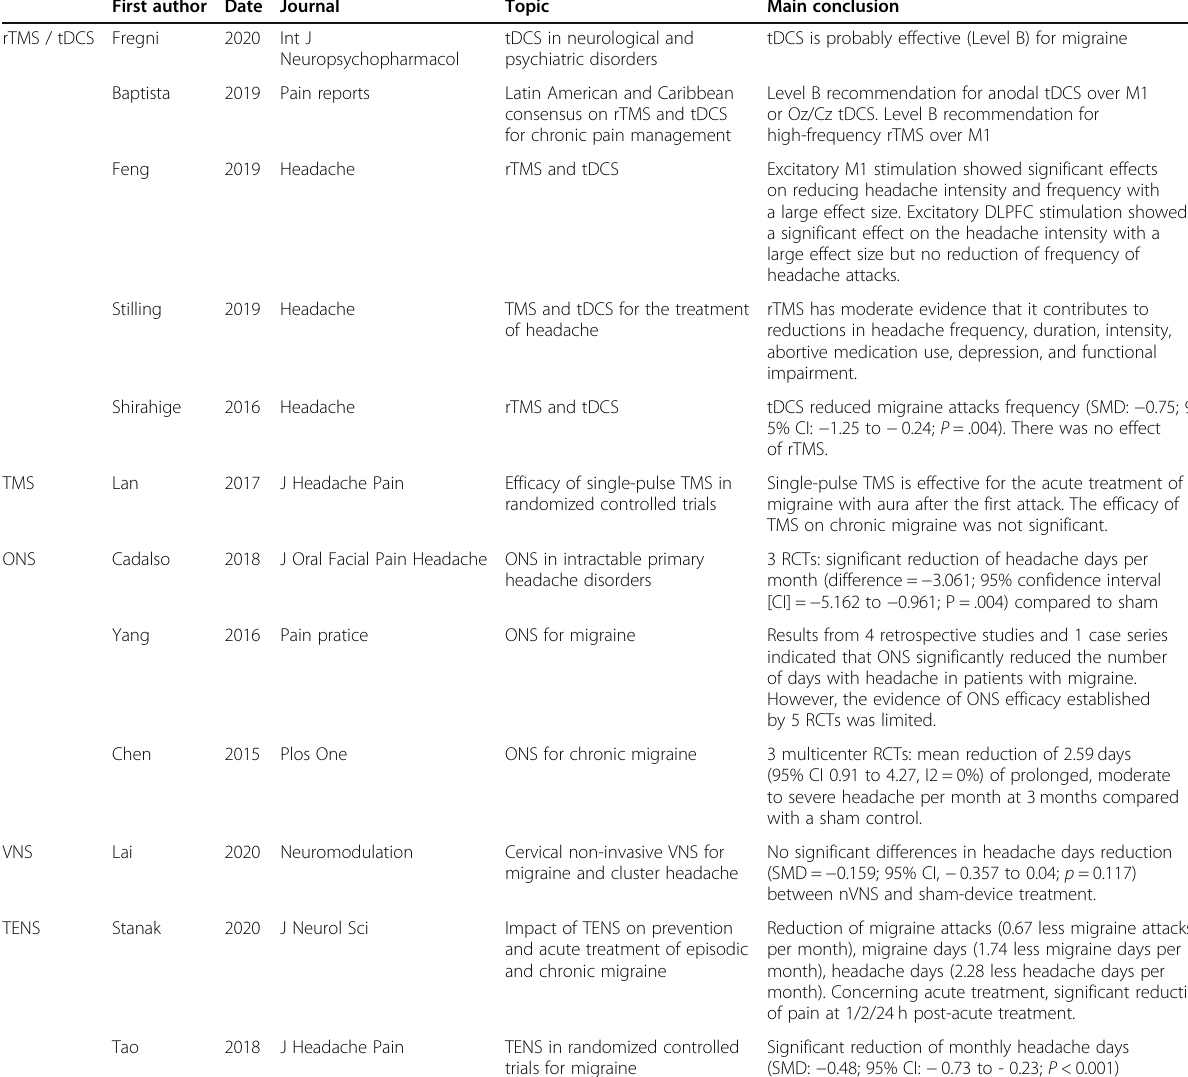
Table 2 Summary of the main results of previous systematic reviews and meta-analysis focusing on neuromodulation in migraine